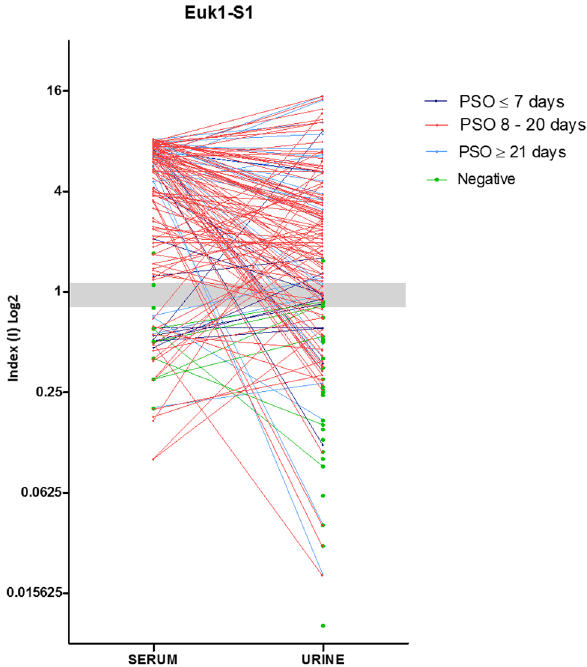
Figure 2. Evaluation of comparative urine and serum index values (I) for each patient according to the days Post-Symptoms Onset (PSO) by using rSARS-CoV-2 Euk1-S1 protein. The index values obtained from urine and serum samples for each patient are represented by circles and when paired they are interconnected by lines, each color being specific to the collection period after the onset of symptoms. Individual data were divided according to the PSO days of the collection date, i.e. at ≤ 7 days, 8 to 20 days and ≥ 21